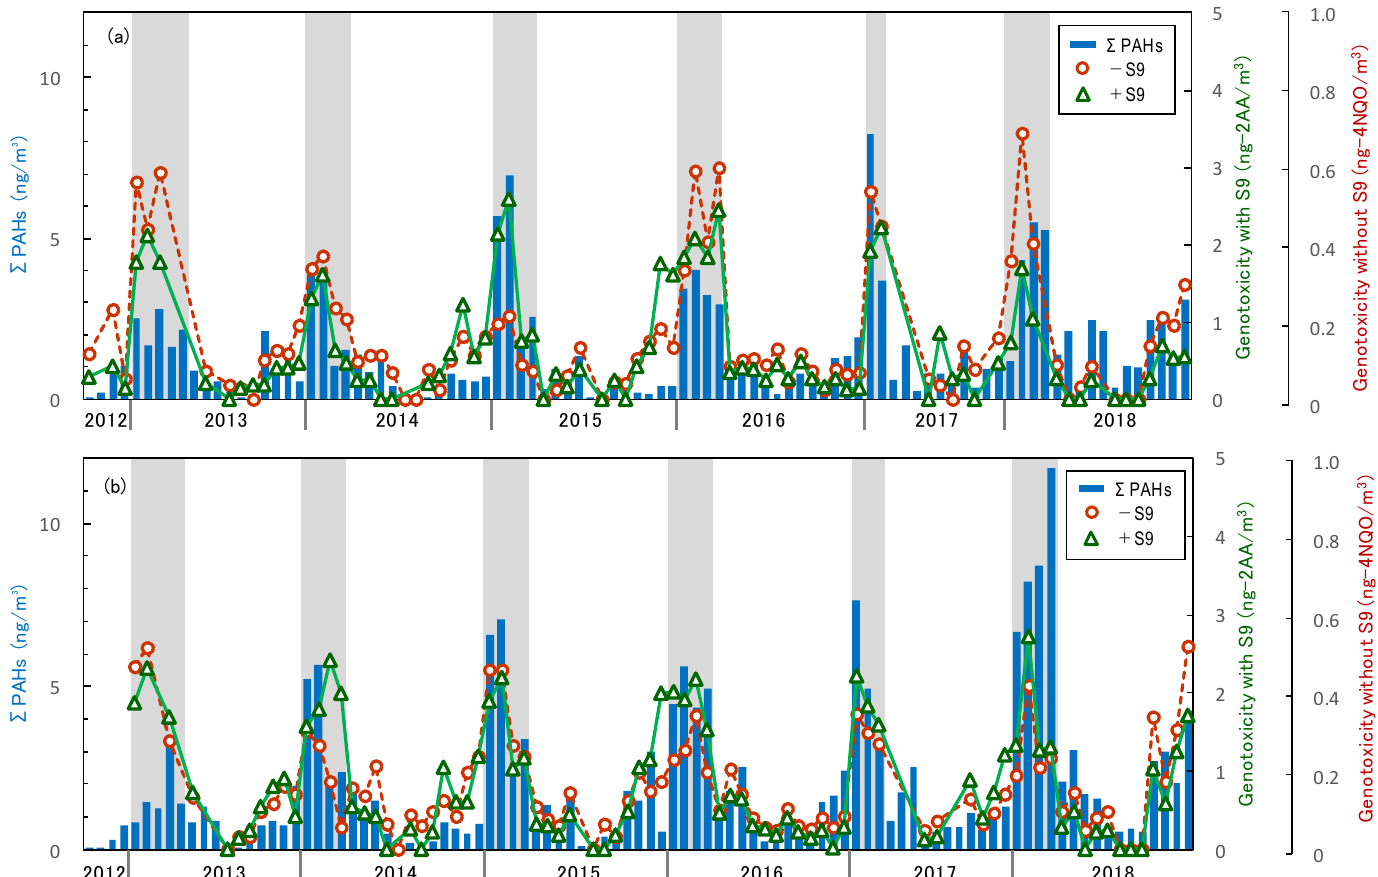
Figure 3. Seasonal fluctuation of PAH concentrations and genotoxicity. The bar graph represents the total PAH concentrations. The circle and triangle plots in the line graph show genotoxicity under −S9 and +S9 conditions, respectively. The gray areas indicate winter data: ( a ) values of the forest site; ( b ) values of the suburban site.